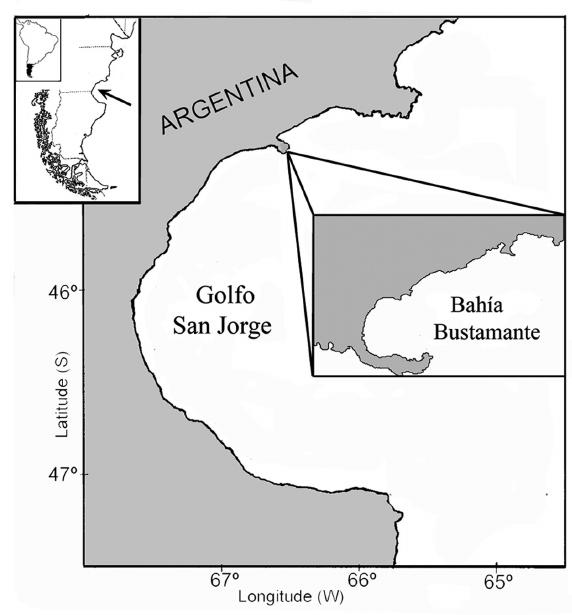
Fig. 1. – Bahía Bustamante, southwestern Atlantic